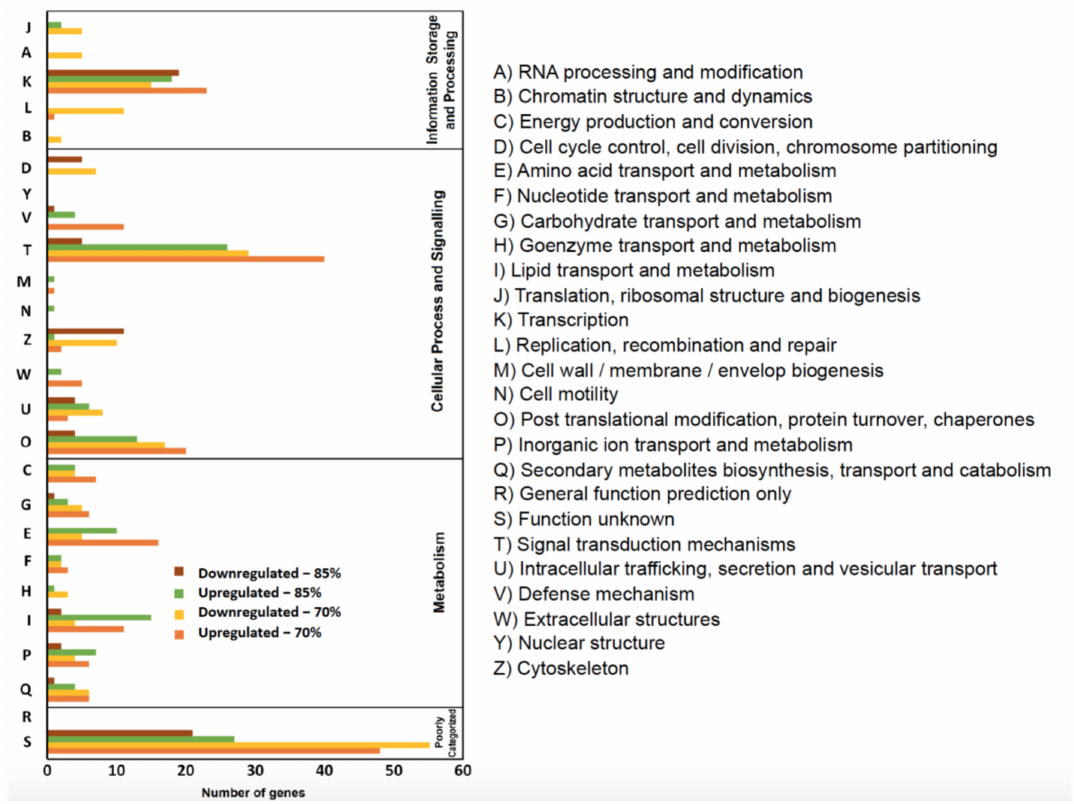
Figure 6. Eukaryotic Orthologous Groups (KOG) functional classification of differentially expressed genes of feed—restricted mid—intestines from two groups were categorized into four main cat- egories: information storage and processing, metabolism, cellular processes, and signaling, and poorly